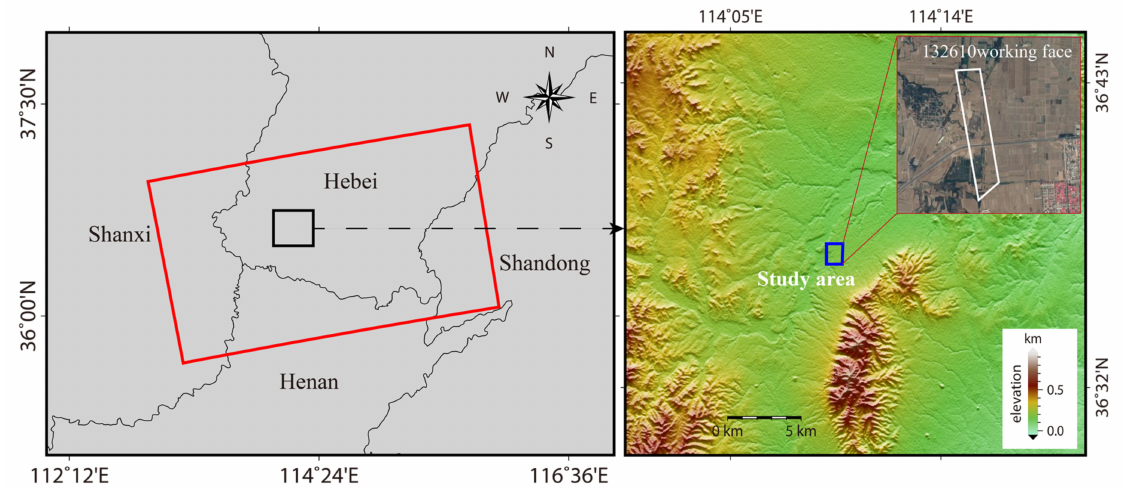
Figure 5. Location of study area (blue polygon) superimposed on the DEM and the coverage area of sentinel-1A image (red polygon) superimposed on the provincial administrative division map. The white polygon represents the 132,610 working surface.